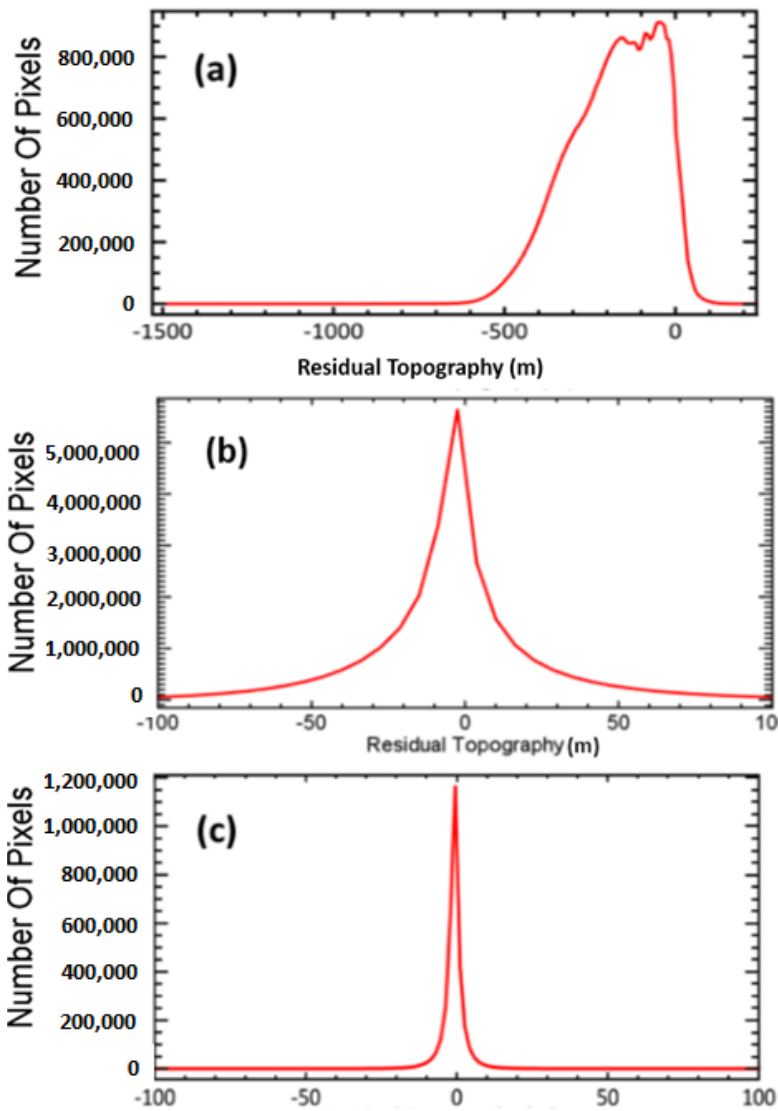
Figure 8. Statistics of estimated residual topography: ( a ) for ALOS-2 interferograms by using the SRTM data, which showed average residual topography equal to − 100 m and high standard deviation equal to 70 m; ( b ) the average residual topography and standard deviation reduced by increasing the wavelet number; ( c ) for Sentinel-1 interferogram with average residual topography to almost 0 m with a standard deviation equal to 13.5 m.